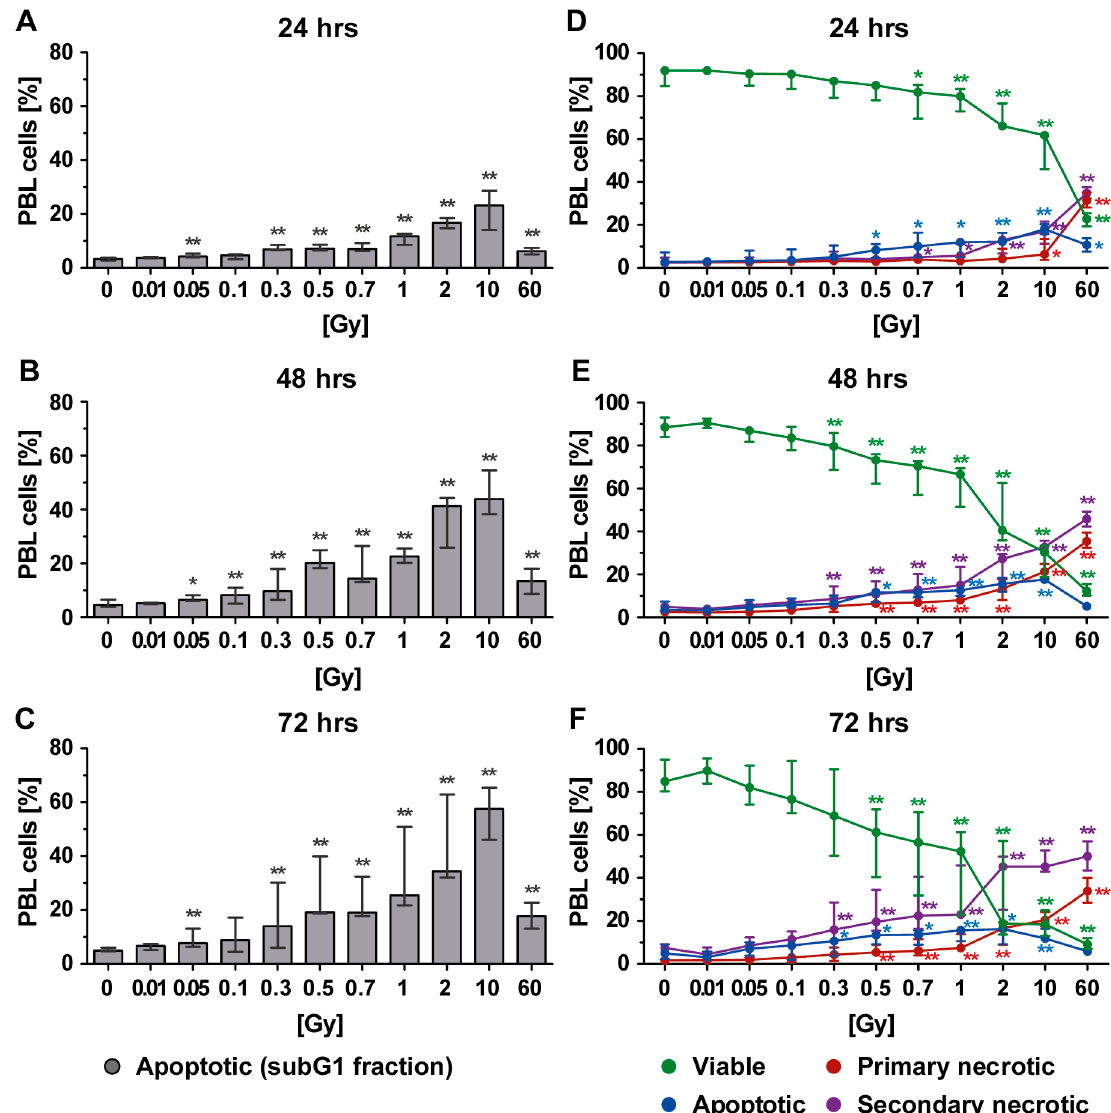
Figure 2. Cell death in peripheral blood lymphoid cells (PBL) at different time points after irradiation as detected by analyses of ( A – C ) subG1 DNA content and ( D – F ) phosphatidylserine exposure and membrane permeability of PI with AxPI staining. Each data point represents the median (±interquartile range (IQR)) from six experiments from three different donors. Data points have been connected by lines to improve visual clarity. Statistical analyses were performed against the corresponding nonirradiated control (0 Gy) using the Mann–Whitney U test (*: p < 0.05; ** p < 0.01).